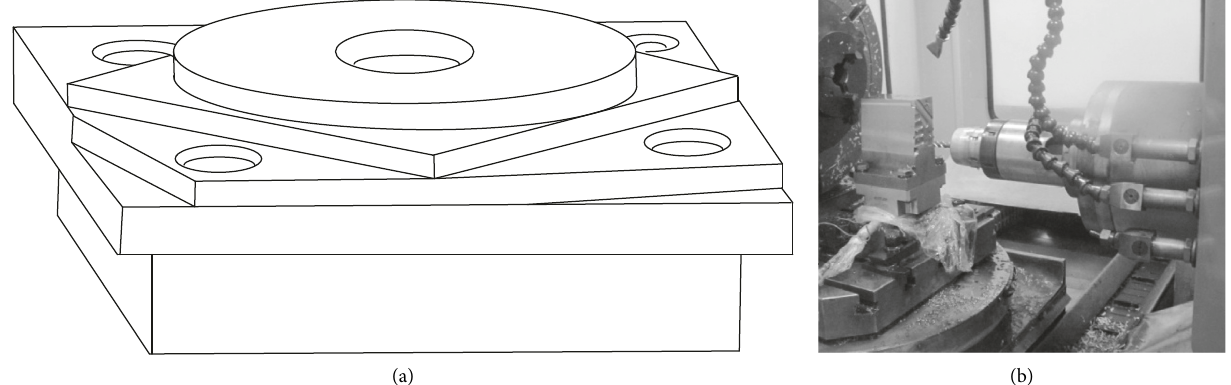
Figure 10: The 3D model and part machining. (a) The 3D model of the test piece. (b) Part machining on the four-axis machine tool.